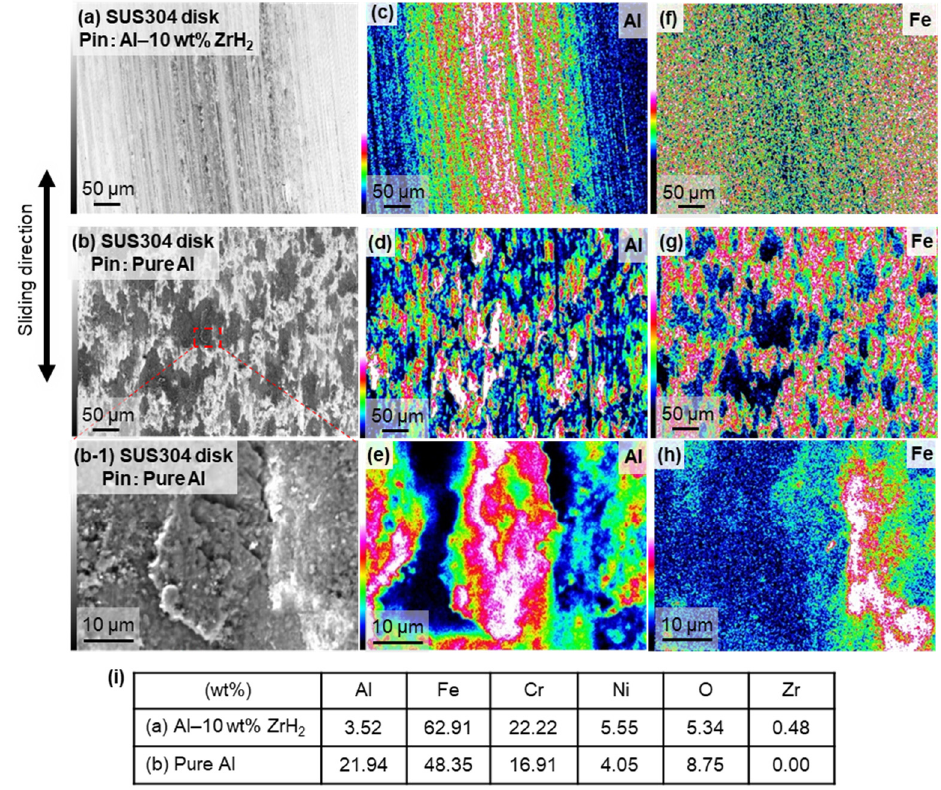
Figure 9. SEM–EDS analysis on the wear track of the SUS304 disc under an applied load of 4.9 N using ( a ) Al–10 wt% ZrH 2 , ( b ) pure Al pin specimen, and ( b-1 ) high magnification image of ( b ). ( c – h ) The corresponding Al and Zr elements distribution maps in ( a , b , b-1 ). ( i ) The quantitative EDS analysis results of ( a ) and ( b ).